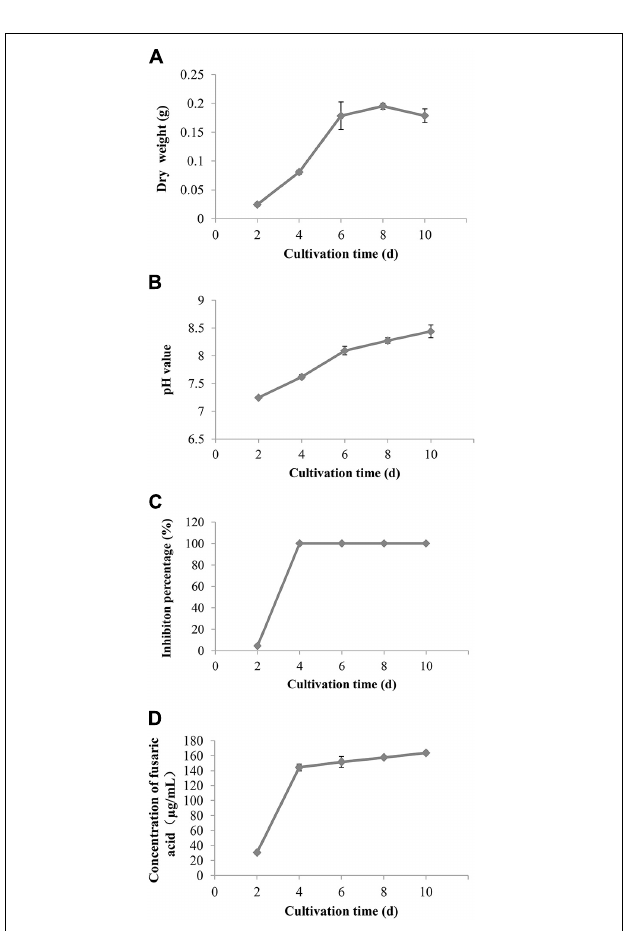
FIGURE 5 | The change of the biomass (A) , pH value (B) , inhibition rate (C) , and content of fusaric acid (D) of the culture filtrates of F. proliferatum 10R-7 on V. dahliae at different culture